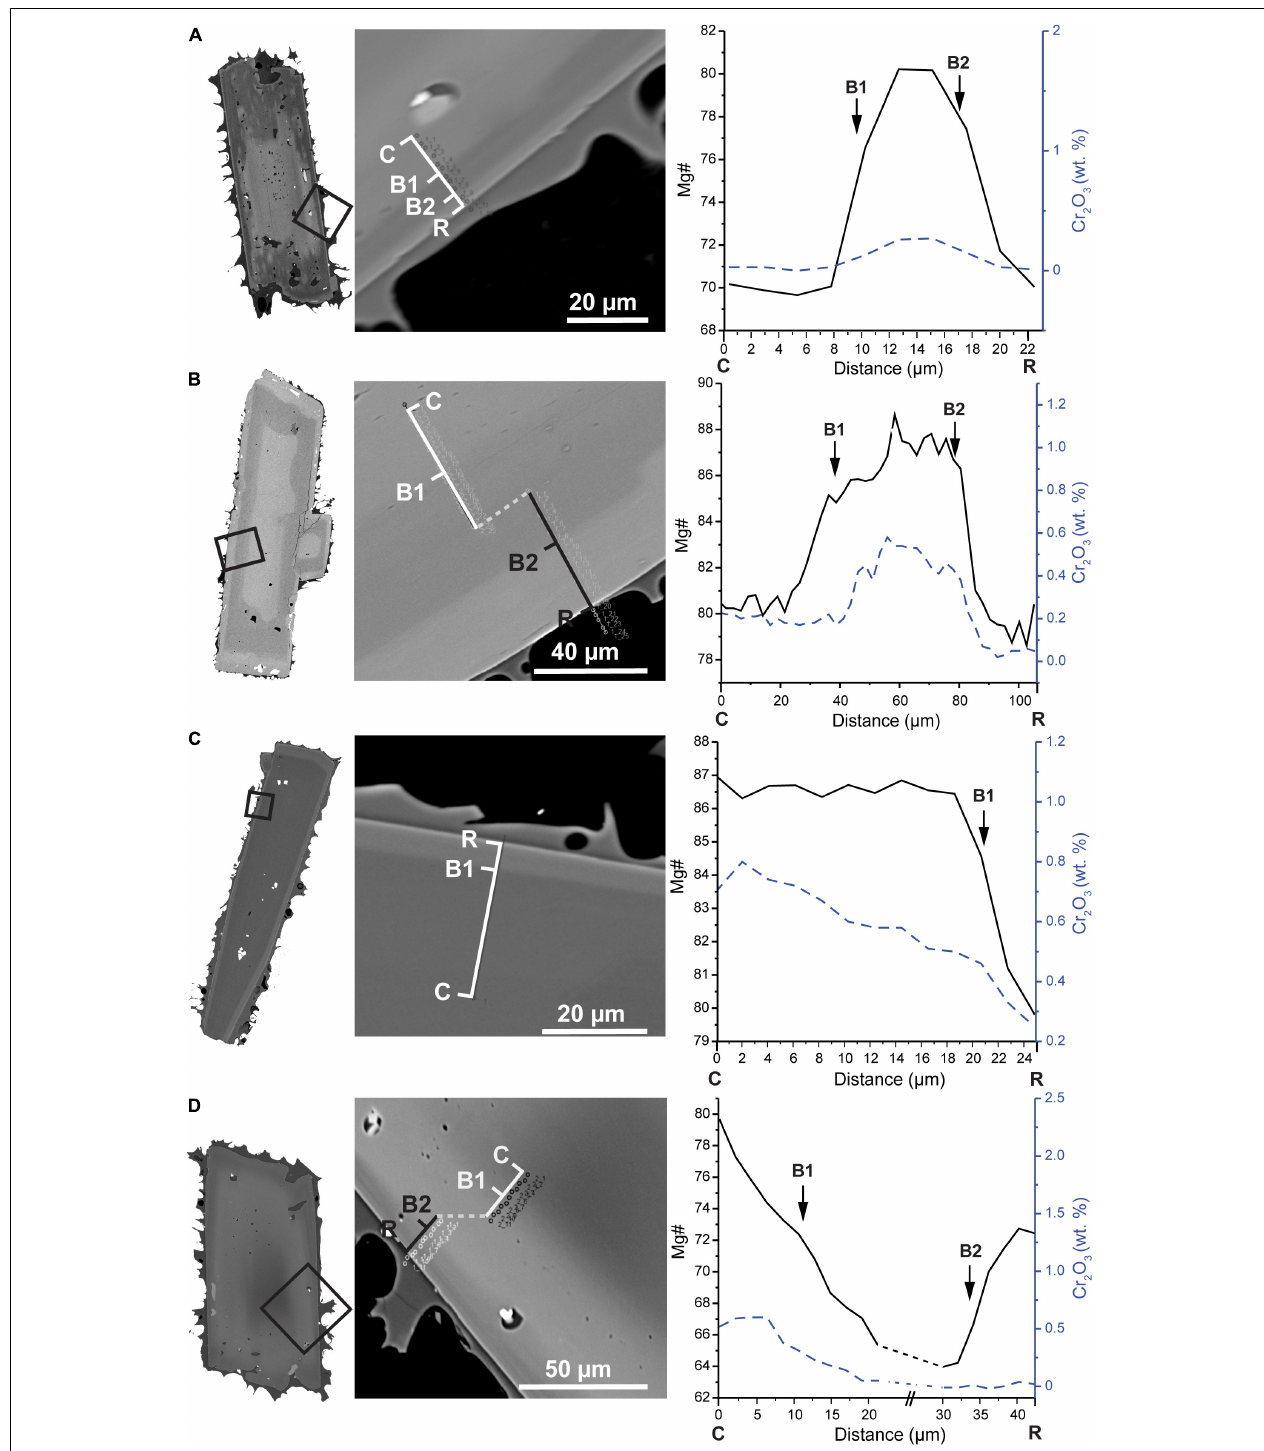
FIGURE 6 | Compositional traverses through representative orthopyroxene and clinopyroxene crystals. Arrows indicate (former locations of) resorption horizons. Plots show Mg# (solid black) and Cr 2 O 3 (dashed blue) concentrations along the transect outlined in close up BSE images. C = Core; B = Band; R = Rim. (A) T1b orthopyroxene without inclusions, surrounded and partially resorbed by Mg-Cr-rich band and < 5 µ m wide evolved outer rim. Sample POP-112 (Pink Pumice, PP). (B) T1b clinopyroxene with rounded, embayed core, 40 µ m wide Mg-Cr rich band, and evolved, slightly resorbing rim of ∼ 25 µ m width. The core-band transition is diffused, whereas the band-rim boundary is discrete and well-defined. Sample POP-63 (Yellow Pumice). (C) T2 orthopyroxene with Cr-spinel-inclusions in core and well defined ∼ 5 µ m wide rim. Sample POP-112 (PP). (D) T2 orthopyroxene with wide diffusive horizon producing gradual normal zoning toward evolved compositions, including apatite toward the rim. Outer rim is ∼ 10 µ m wide and more magnesian than band at unchanged Cr concentrations. Sample POP-112 (PP).